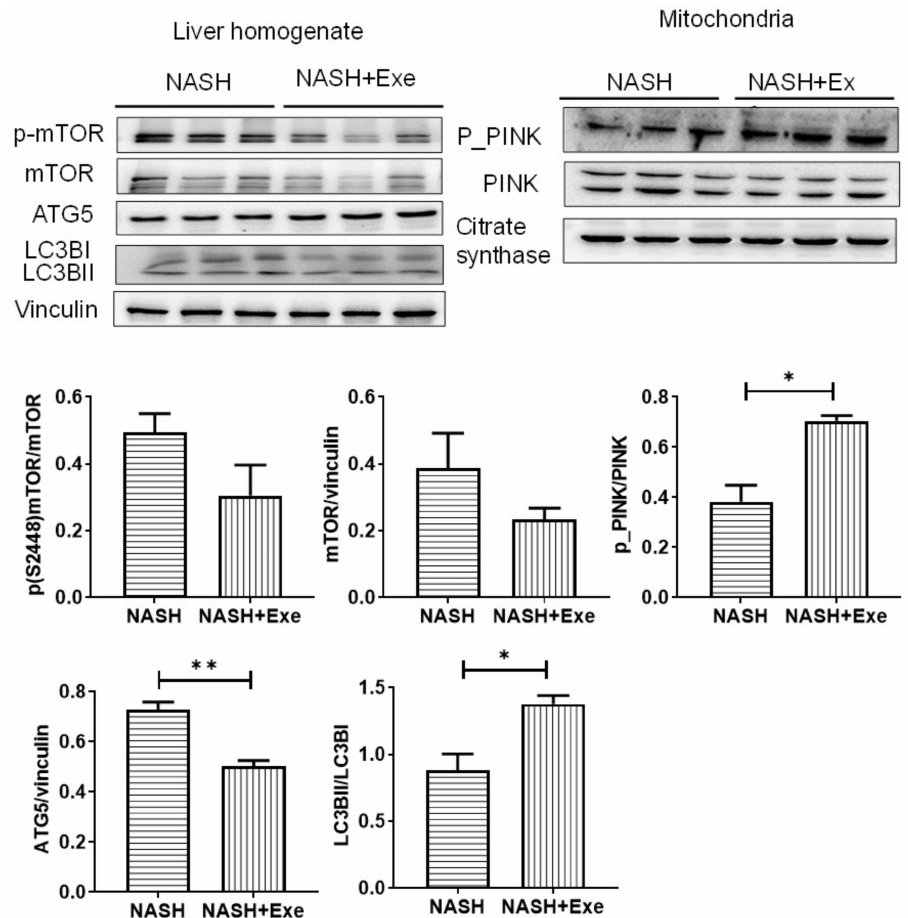
Figure 8. E ff ect of exercise on autophagy. Immunoblots of protein expression (upper panels) and quantification (lower panels) in liver homogenates (left panel) and mitochondria (right panel) for markers of autophagy in the NASH sedentary and NASH + EXE groups. mTOR and its phosphorylation tended to decrease in the NASH + EXE group. Autophagy related gene 5 (ATG5) tended to decrease in the NASH + EXE group. The ratio of light chain 3BII (LCBII) to LCBI was increased in the NASH + EXE group ( p < 0.05). Vinculin served as the loading control. The phosphorylation of PTEN-induced kinase (P-PINK) increased in mitochondria of the NASH + EXE group ( p < 0.05). Citrate synthase served as the loading control. Groups are as described in Figure 1 (unpaired t -test; * p < 0.05; ** p < 0.005). For more details of Western blots, please view Figure